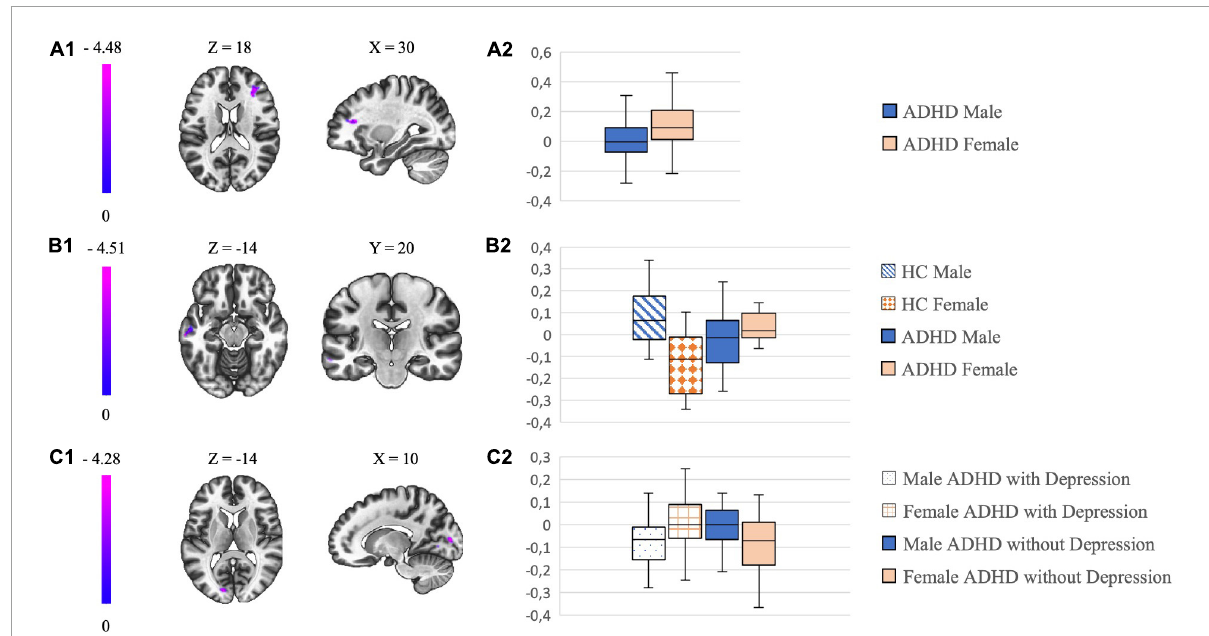
FIGURE1 The left column shows in (A1–C1) the most significant clusters of the different connectivity analysis and their localization. The color-coding bar depicts the voxel-wise T -values. The column on the right with box plots in (A2–C2) show the mean beta values extracted from the respective cluster which is illustrated on the